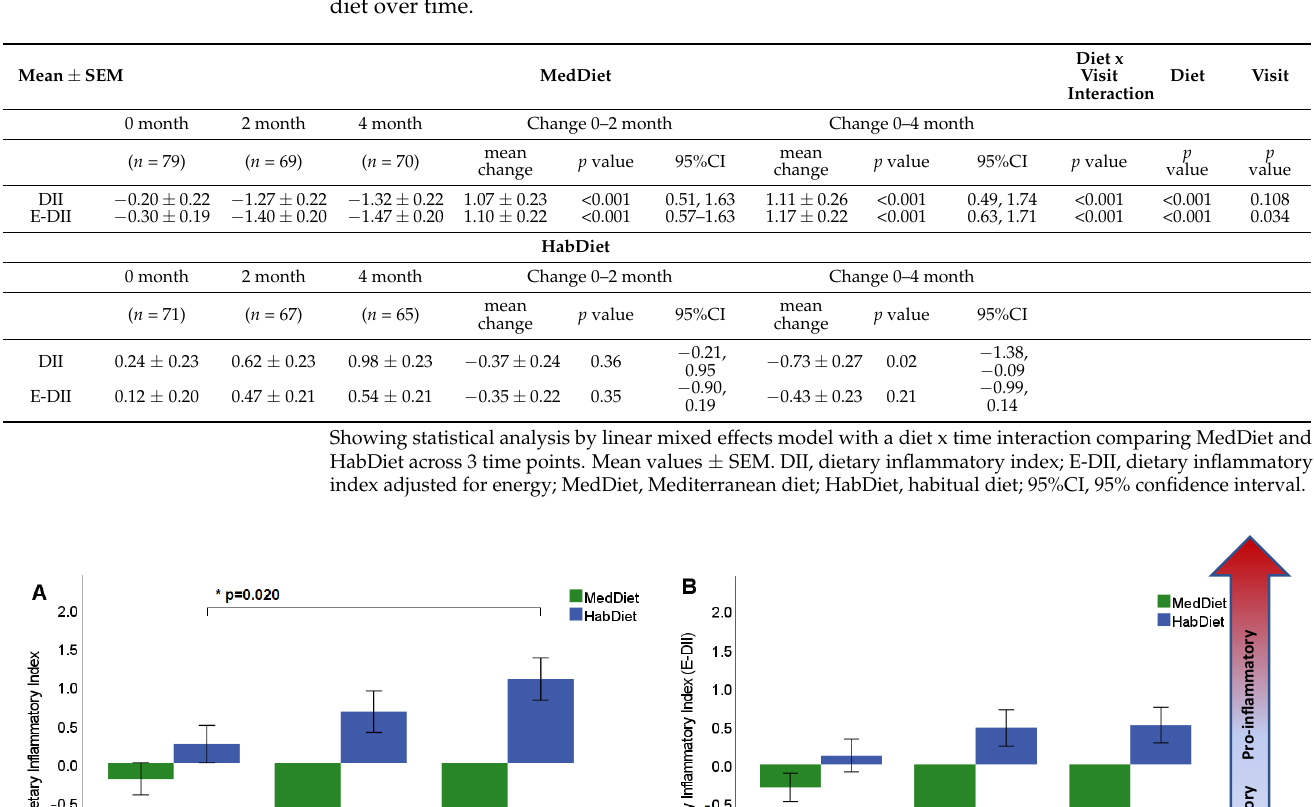
Table 1. Comparison of dietary inflammatory index score between Mediterranean diet and habitual diet over time.